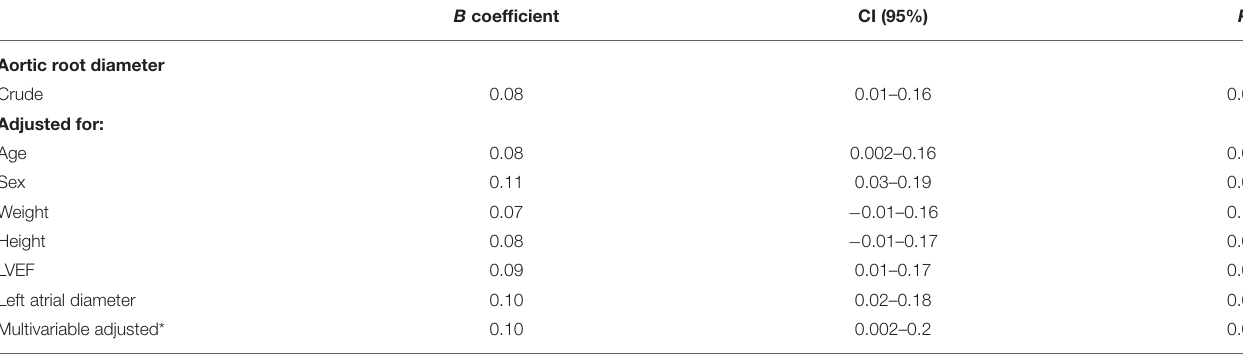
TABLE 2 | Crude and adjusted linear regression coefficients between aortic root diameter and atrial septal mobility (ASM). B coefficient CI